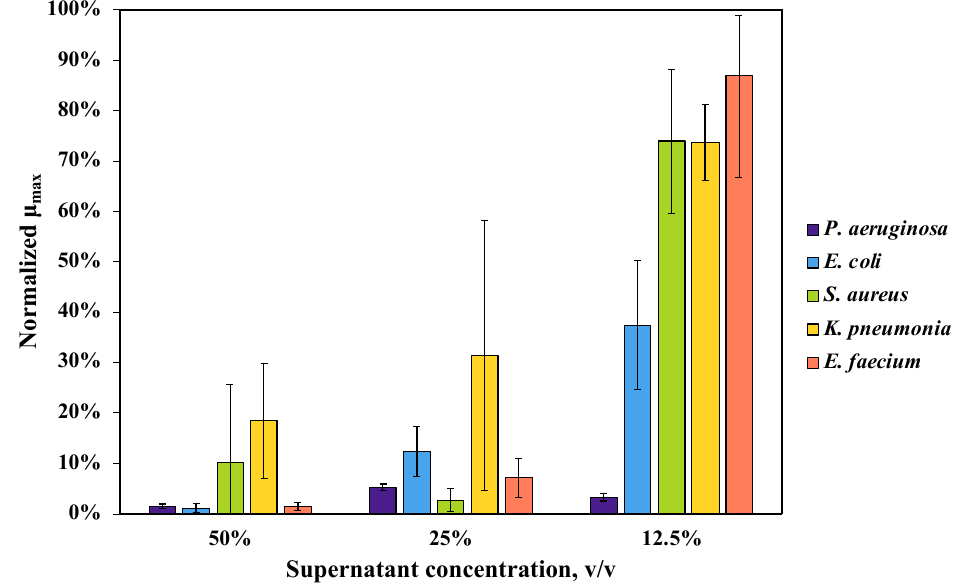
Table 1. Inhibition zones in E. coli agar overlays with several Z. mobilis strains.